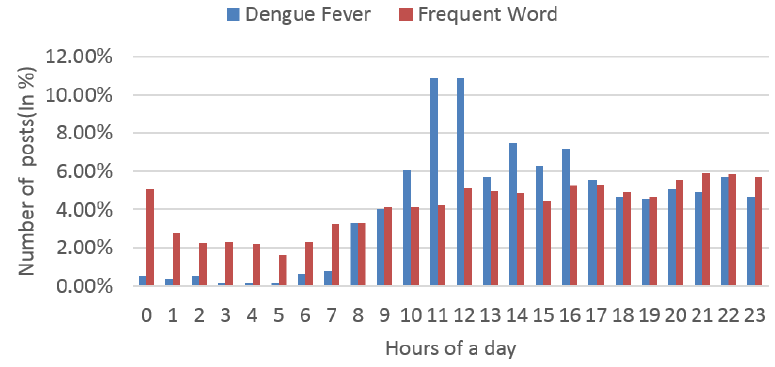
Figure 8. The trend on one day, 22 September 2014.